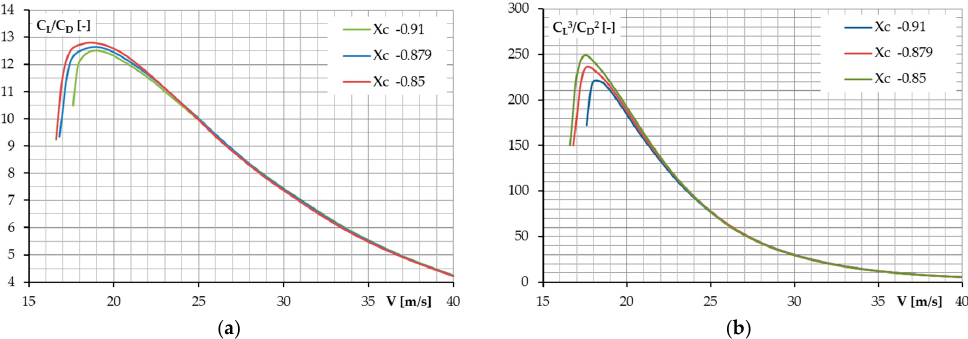
Figure 15. The airplane’s aerodynamic characteristics’ variation with the centre of gravity (CG) position: ( a ) C L / C D ratio; and ( b ) power coefficient C L3 / C D2 with respect to the airspeed.